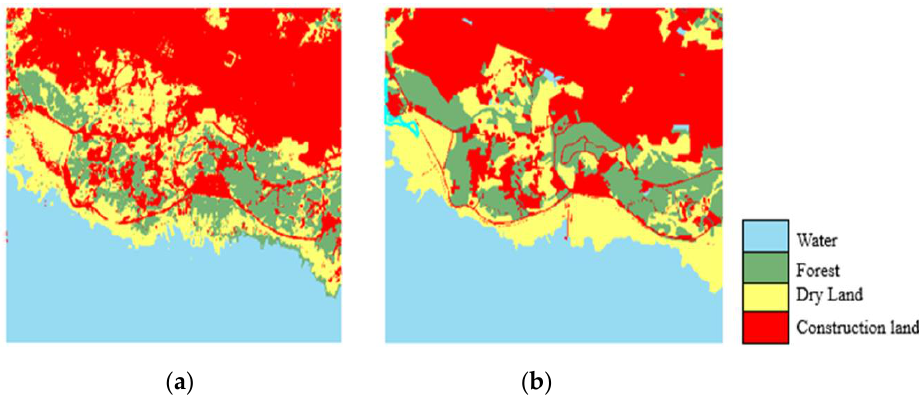
Figure 5. ( a ) Supervise classification results; ( b ) Data of China's Third National Land Survey.